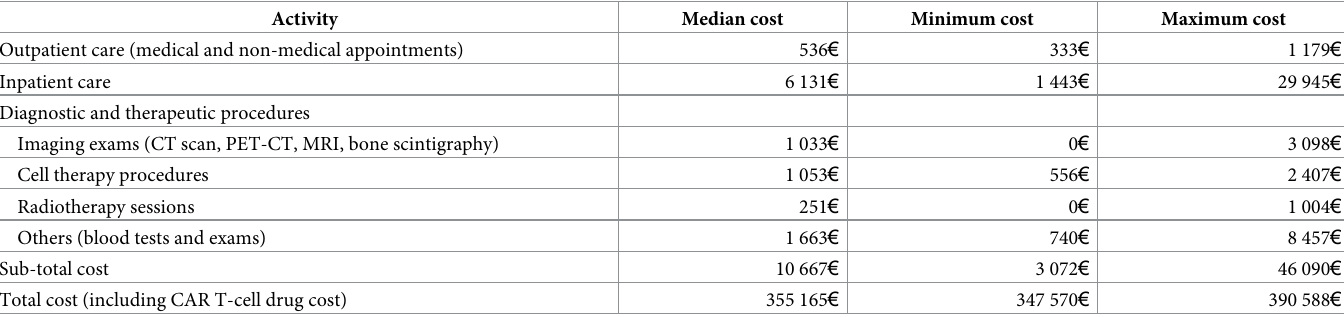
Table 6. Costing by